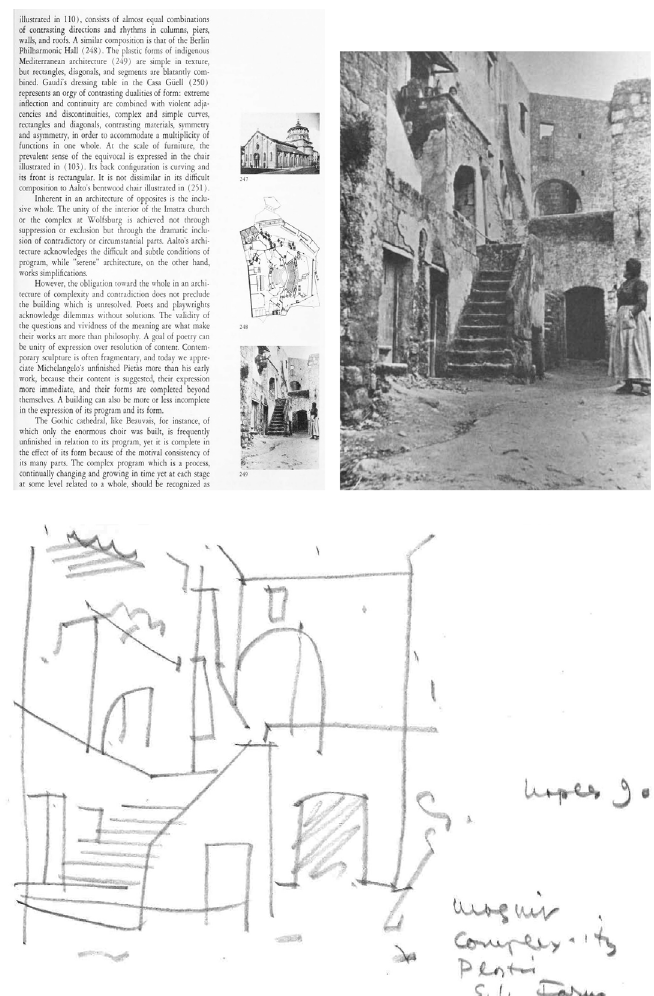
Fig. 9 Page 101 excerpted from Chapter 10 related to figure No. 249 and its drawing made by Robert